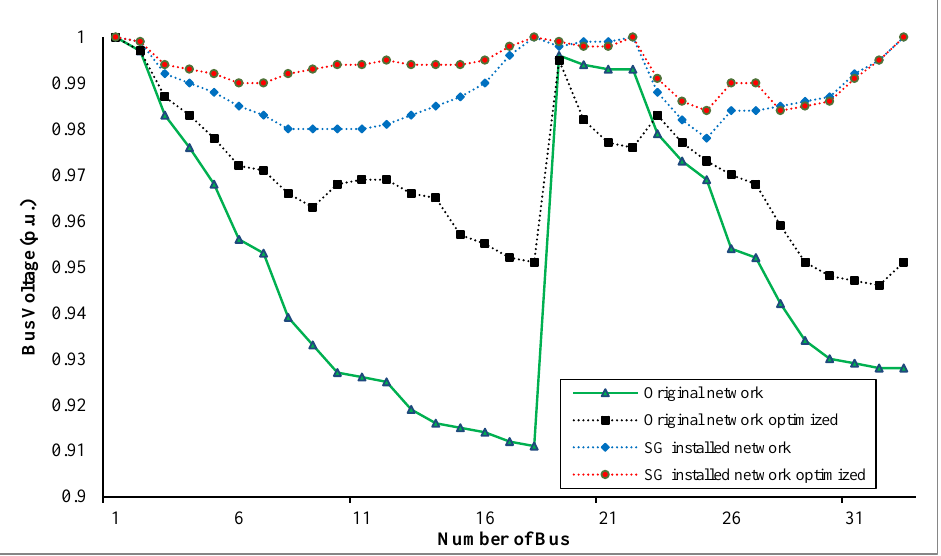
Figure 8. Voltage profile of IEEE model distribution network 33-bus.